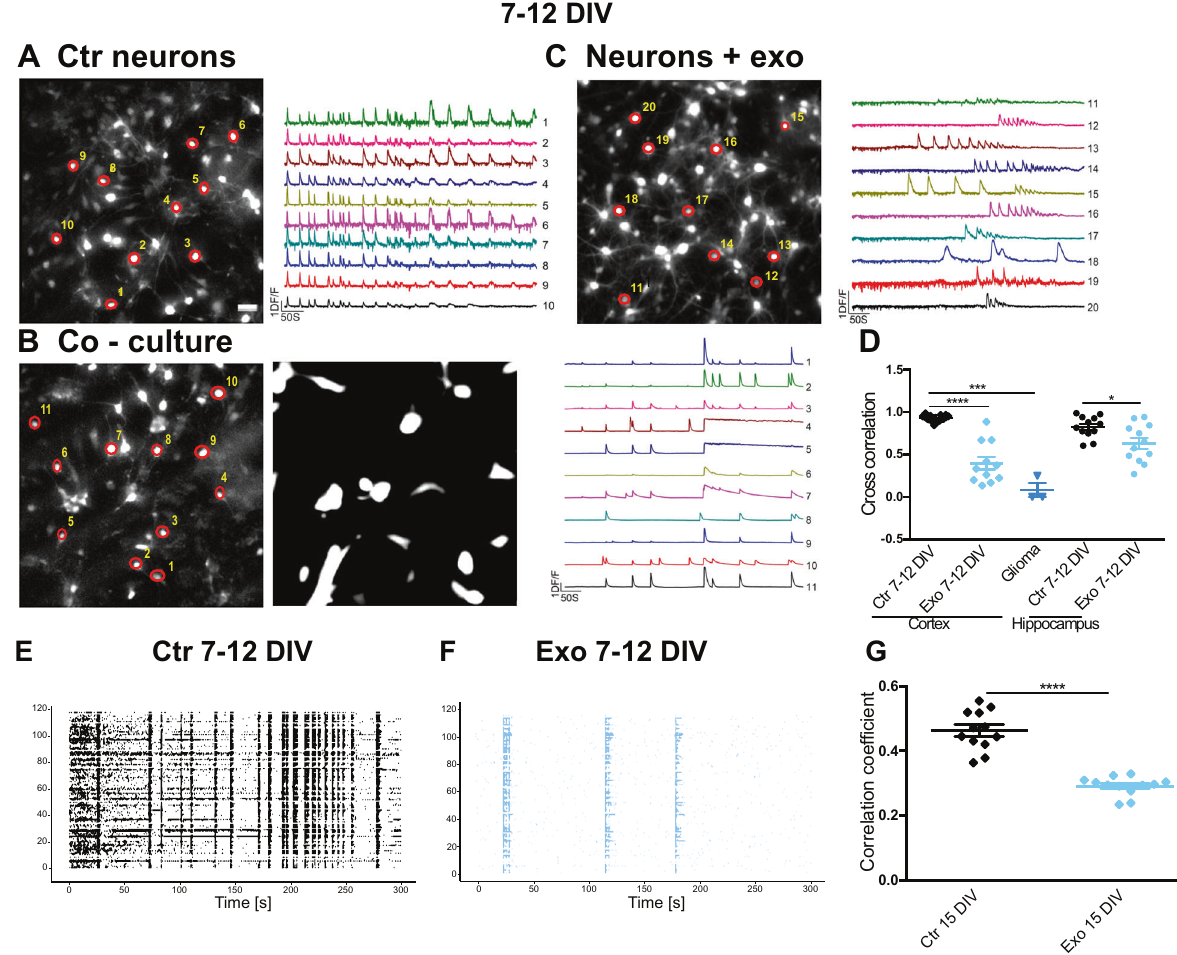
Fig. 2 Glioma cells-derived exosomes disrupt network synchrony in mature (DIV 7 – 12) primary neuron cultures. A – C Representative images of a Fluo-4 loaded DIV 10 control cortical neuron culture ( A ), of neurons co-cultured for 1 day with U87, mCherry expressing, glioma cells ( B ), and of neurons exposed for 1 day to U87-derived exosomes ( C ). ROIs indicate cells from which the representative Ca 2 + traces are extracted. Scale bars, 50 µm. D Cross-correlation values of the various experimental groups. Data are shown as average ± standard error, signi fi cant differences were assessed with Wilcoxon – Mann – Whitney U test (to compare two groups) or Kruskal-Wallis test followed by Dunn ’ s multiple comparison post hoc test (to compare more than two groups); * p < 0.05; *** p < 0.001; **** p < 0.0001; n = 3 independent cell preparations, four coverslips for each preparation were analyzed and reported as superimposed individual points. E Representative raster plots of spike times, simultaneously detected at 120 spatial channels by MEAs: channels ’ numbers are indicated on the y -axis. The spiking activity is displayed over a representative time window of 5 min, preceding the exposure to U87 exosomes (Ctr). At this stage of development (DIV 7 – 12), network bursts are normally observed. F Representative recording of the same neuronal culture in E after 24 h exosome exposure (Exo), showing a lower occurrence of network bursts. G Pearson correlation coef fi cients among spike times in different channels over 15 min recordings. The average correlation values across 10 channels were analyzed and their distributions were compared under control conditions and after exosomes, exposure using the Wilcoxon – Mann – Whitney U test; *** p < 0.001; n = 12, an average of 10 frequency (Fig. 3C). Importantly, exosomes derived from non- transformed human astrocytes did not change the physiologi- cal properties of the mature neurons (Fig. S6). Altogether, these data show that glioma cells-derived exosomes sharply increases spontaneous and evoked activity in cultured hippocampal neurons. Glioma cells-derived exosomes increase connectivity in DIV 4 neuron cultures Induction of synchrony at DIV 4 is likely caused by increased connectivity, which could originate from a higher number of synaptic contacts and/or increased synaptic ef fi cacy. Genomic screening of the content of glioma-derived exosomes shows an abundance of the Arp2/3 complex [37], which promotes the branching of actin fi laments and in cancer cells promotes